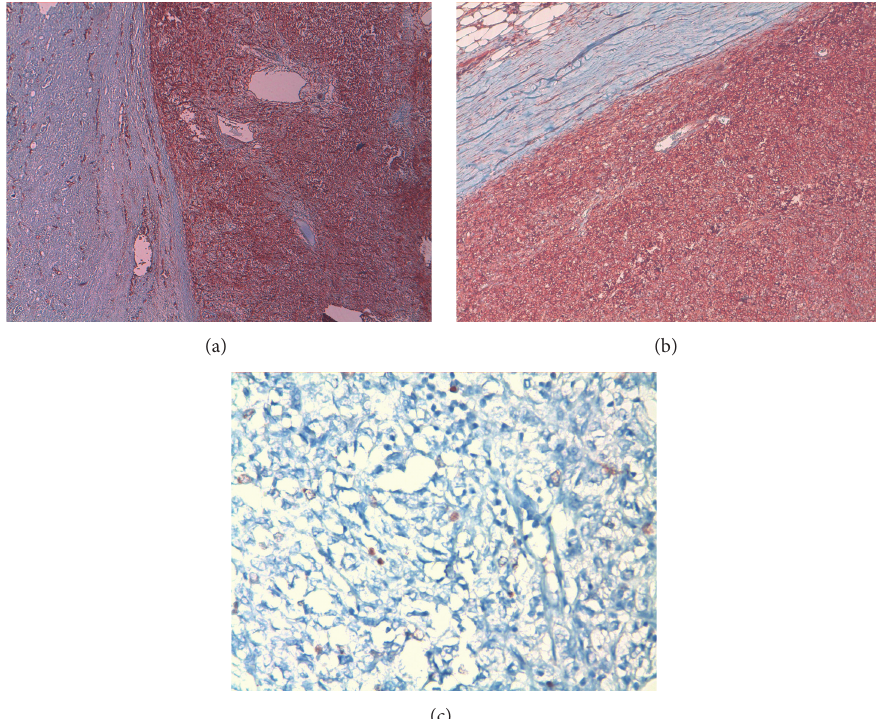
Figure 3: Immunohistochemical staining: (a) CD34 positive ( × 40), (b) CD99 positive ( × 100), and (c) staining showing a proliferative index of 1% with Ki-67 ( ×